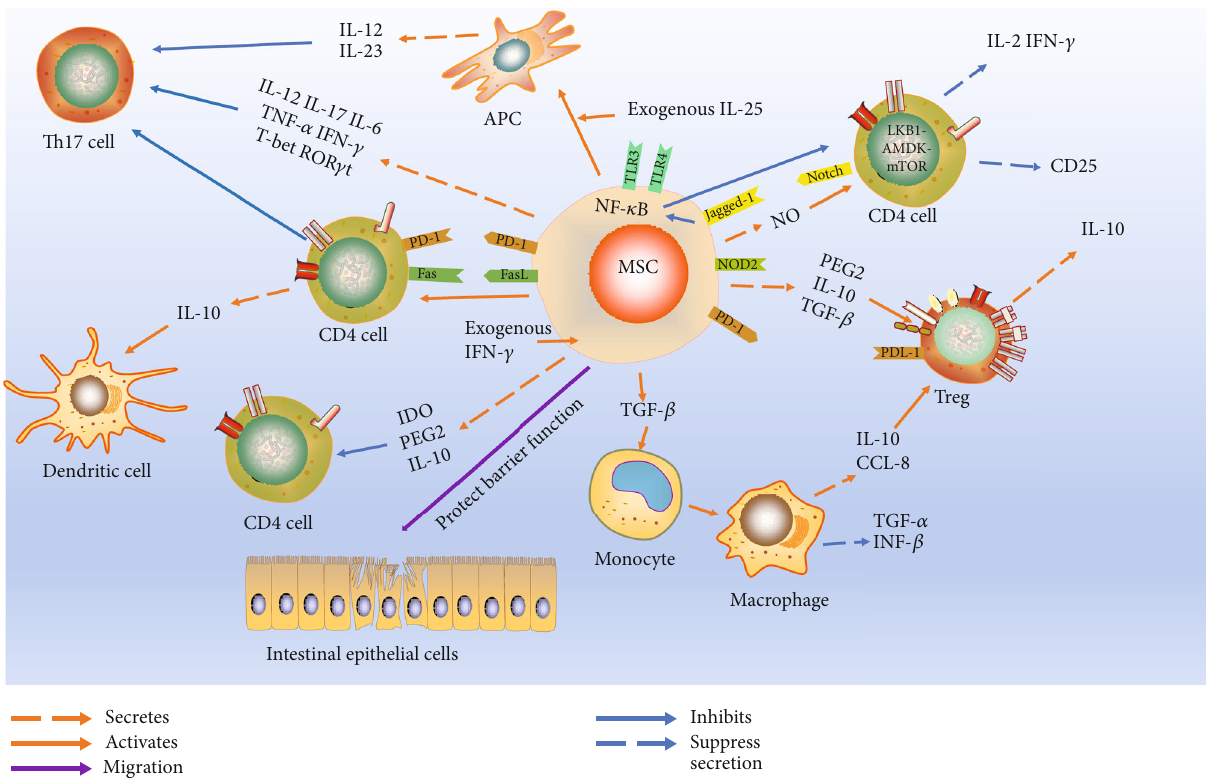
Figure 1: MSCs alleviate IBD by regulating T cells. MSCs induce CD4 T cells to di ff erentiate into Treg and maintain Th17/Th1 balance through a series of cytokines and cell-to-cell contact. This results in decreased in fl ammatory activities to repair intestinal in fl